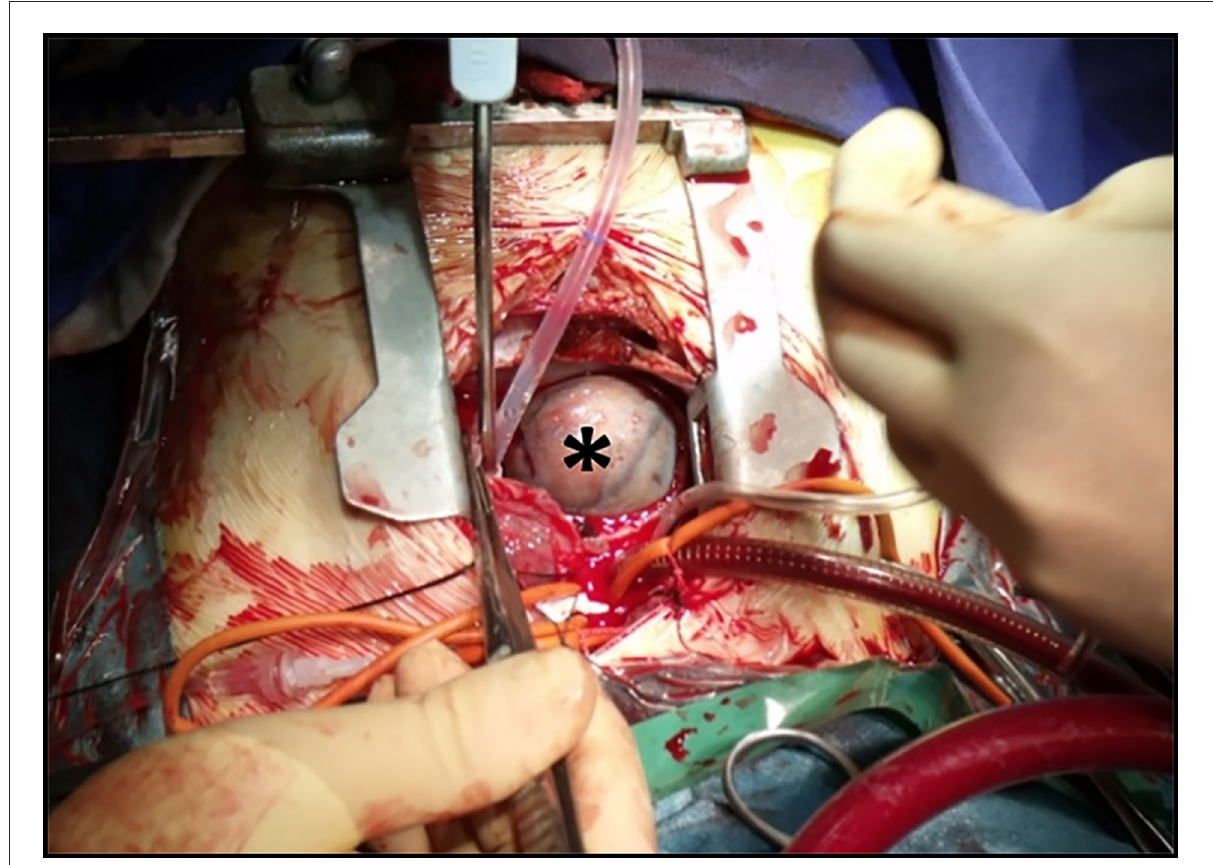
FIGURE2 Intraoperative photograph presenting the right atrial tumor thrombus (asterisk) after performing thoracotomy and